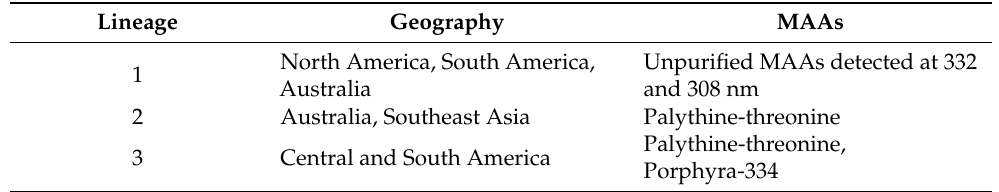
Table 2. Biogeography distribution of MAAs from Bostrychia calliptera